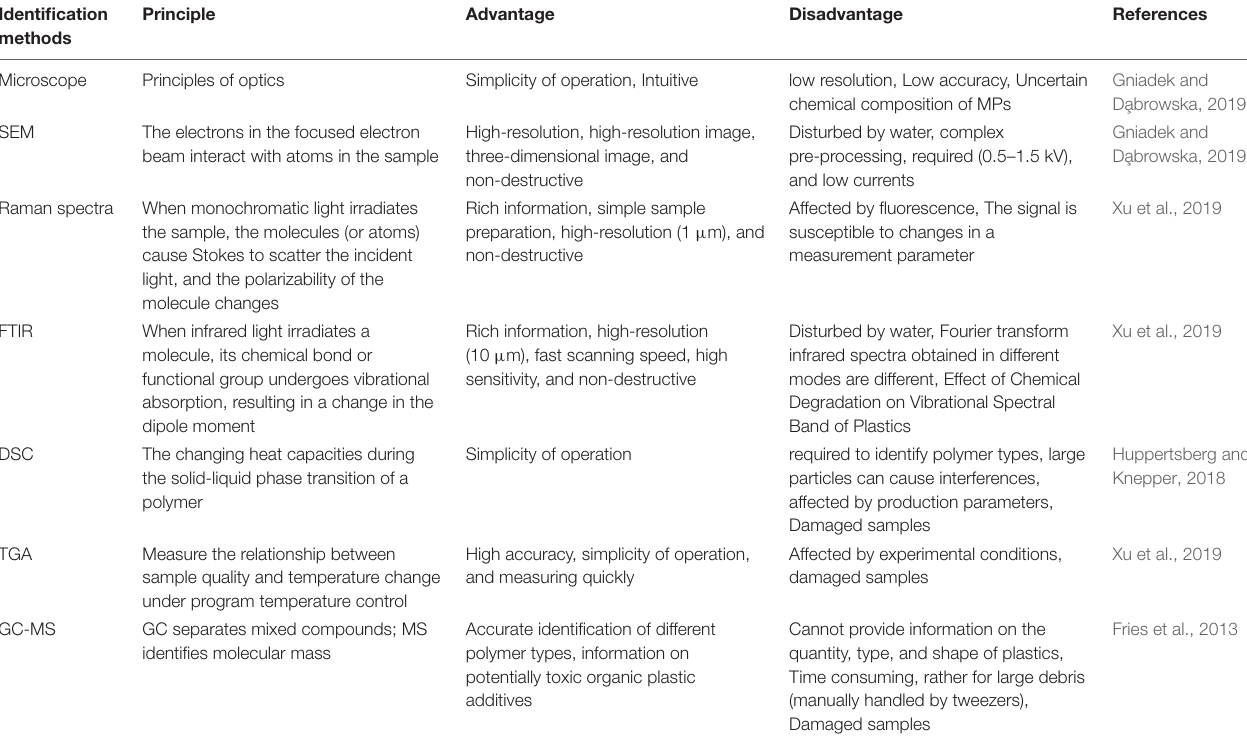
TABLE 2 | Comparison analysis on the major methods for identifying